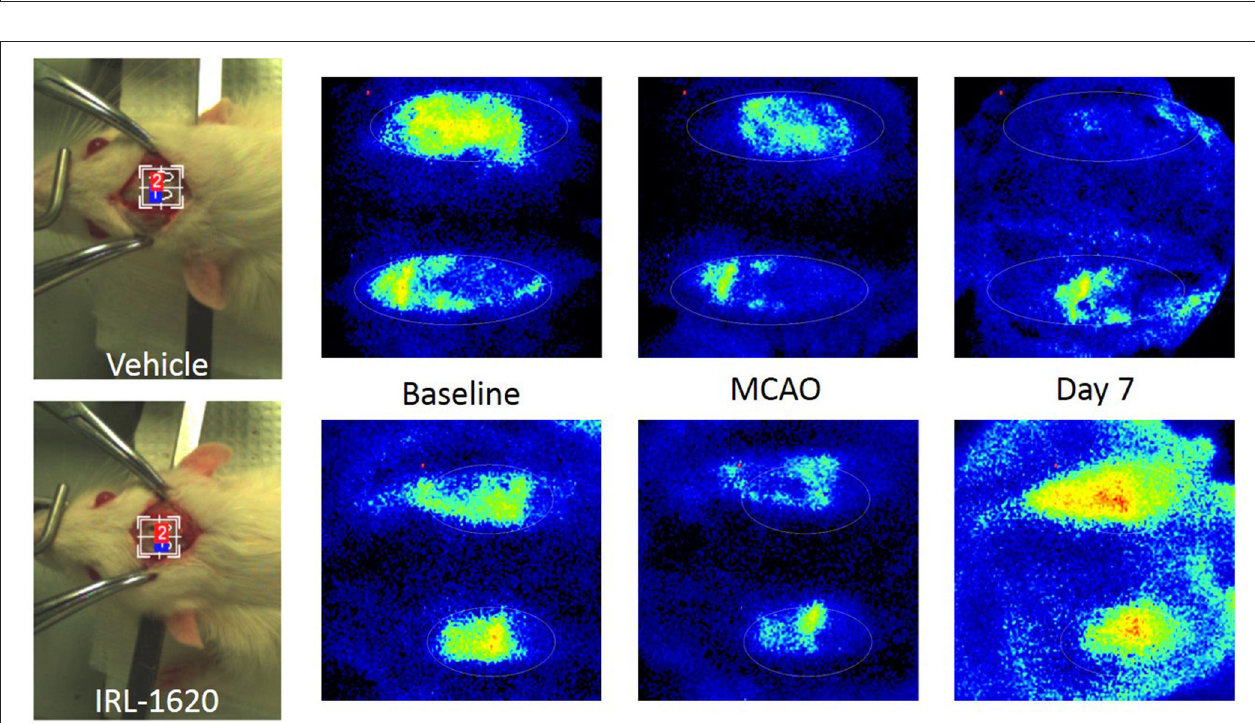
FIGURE 2 | Pericam PSI Laser Speckle Contrast Analysis (LASCA) imaging of cerebral blood flow. Top : Group II (vehicle), left to right: brightfield image, baseline, 1h post MCAO, 7 days post MCAO. Bottom : Group III (IRL-1620), left to right: brightfield image, baseline, 1h post MCAO, 7 days post MCAO.